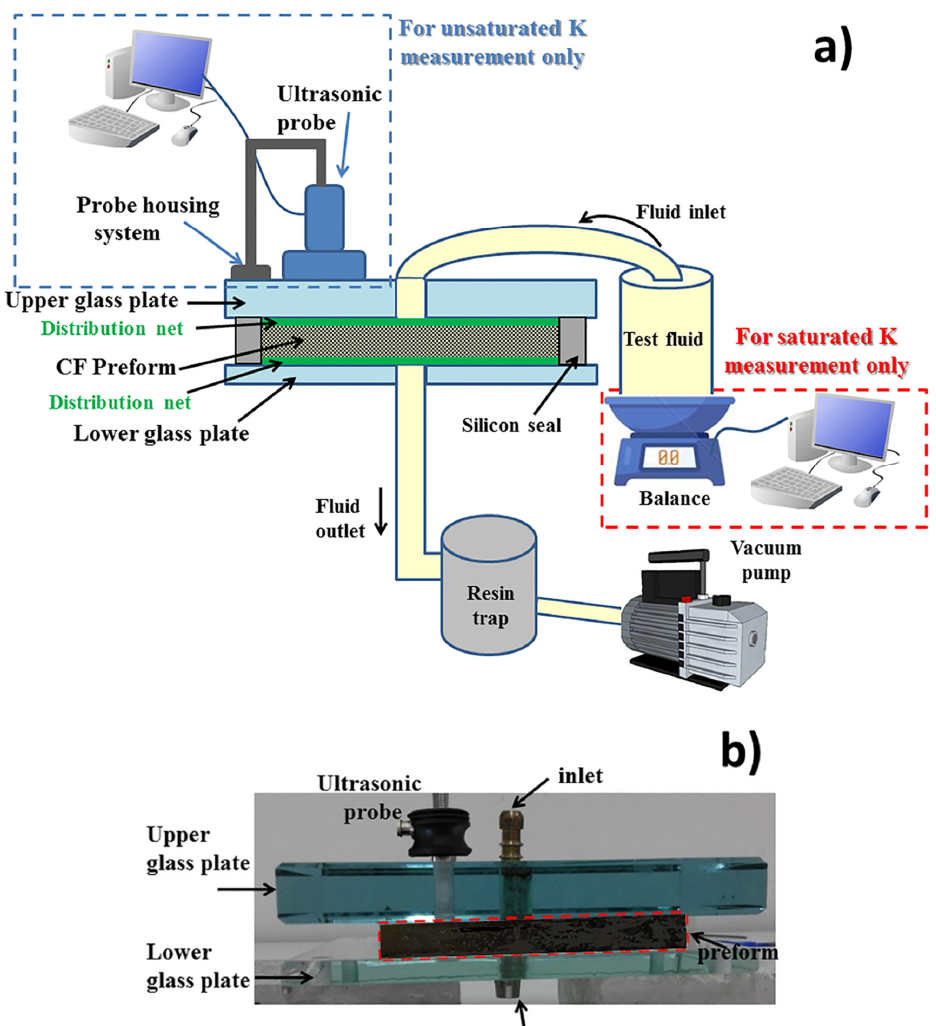
Figure 2. Experimental set-up for out-of-plane permeability measurements by ultrasonic wave propagation: ( a ) general sketch not in scale; ( b ) particular of the ultrasonic measurement device.